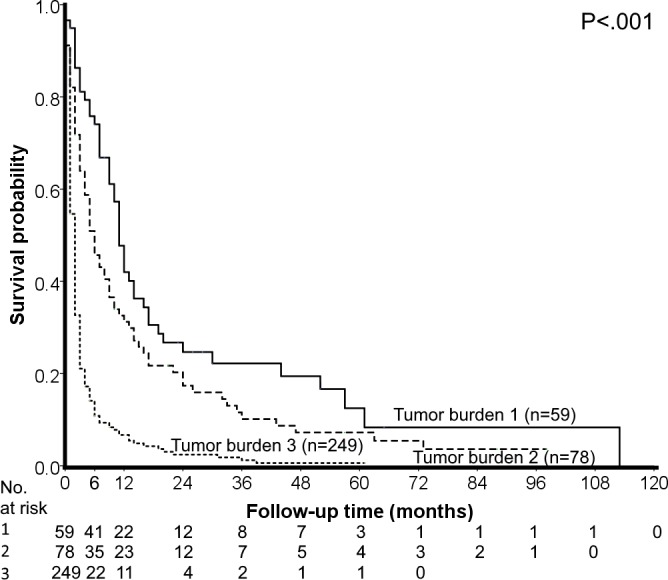
Survival distribution according to tumor burden for all patients.The survival of patients with smaller tumor burden is significantly better than that of patients with larger/more tumor nodule(s).